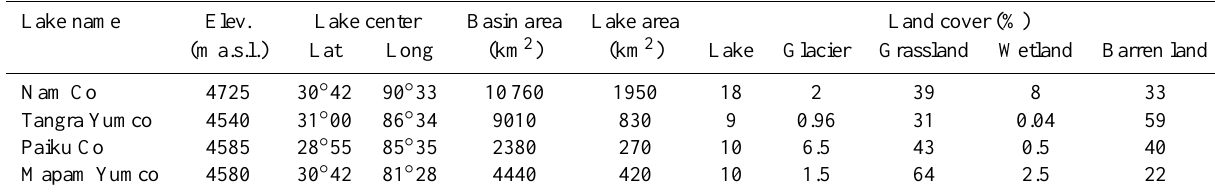
Table 1. Basic information of selected basins in the study region. Data sources are described in Sect. 2.2. Lake name Elev. Lake center Basin area Lake area Land cover (%) (ma.s.l.) Lat Long (km 2 ) (km 2 ) Lake Glacier Grassland Wetland Barren land Nam Co 4725 30 ◦ 42 90 ◦ 33 10760 1950 18 Tangra Yumco 4540 Paiku Co 4585